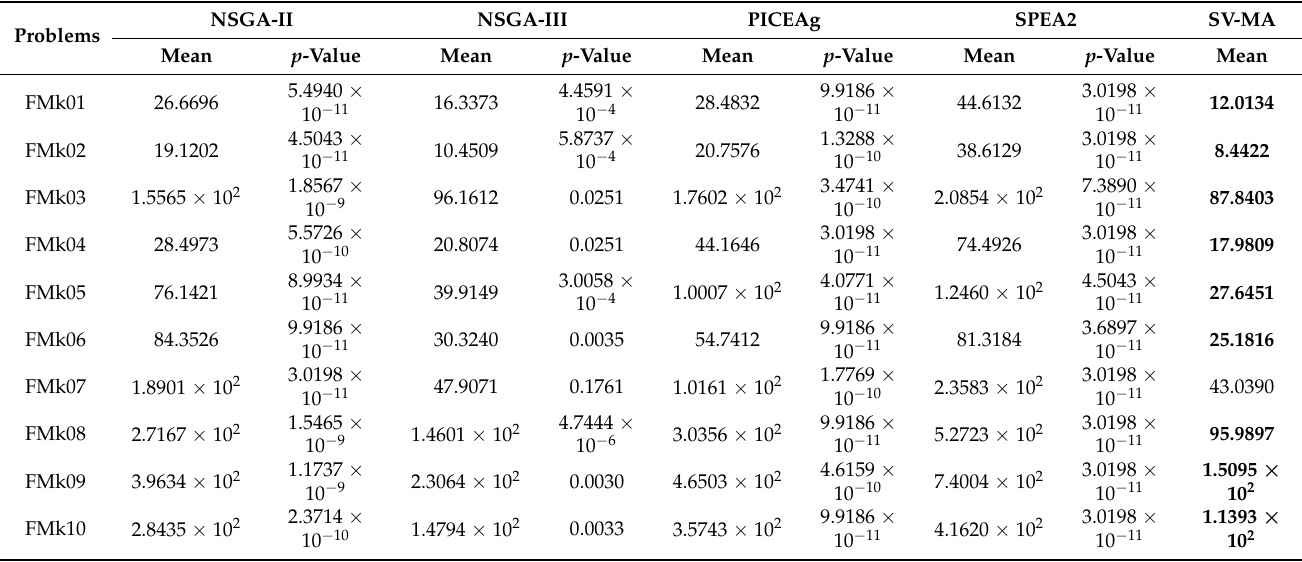
Table 4. Statistical values of